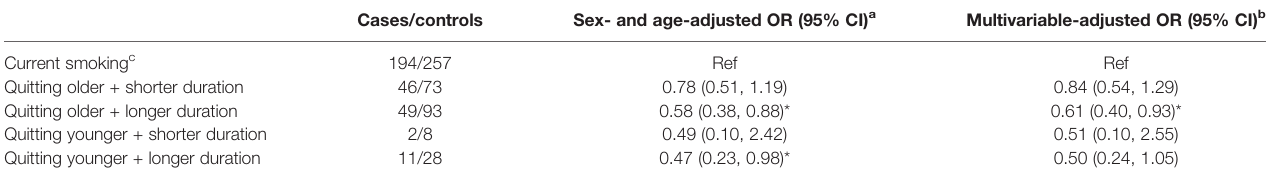
TABLE 3 | Nasopharyngeal carcinoma risk for combinations of quitting duration and age at quitting in subjects aged 18 –